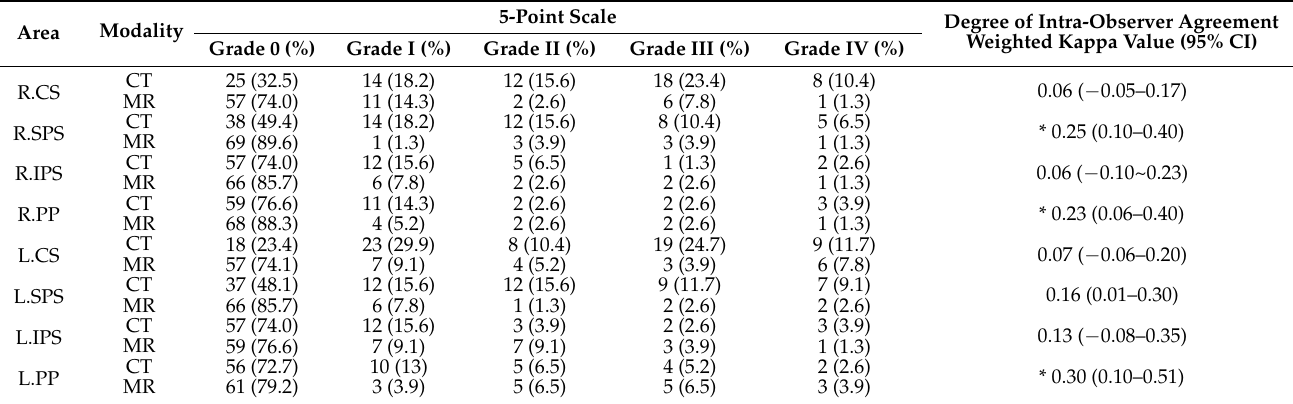
Table 4. Frequency of opacification on brain CTA and flow-related signal intensity on TOF-MRA in the CS, SPS, IPS, and PP by grading in 77 participants (cohort 2).